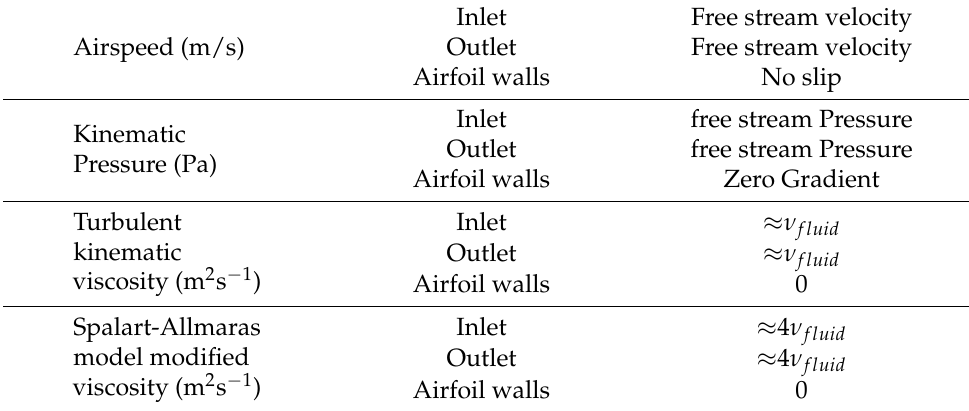
Figure 4. Airfoil dimensions. Table 2. CFD model